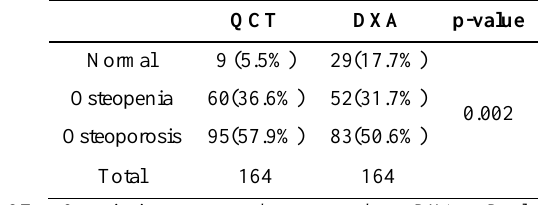
Table 3 : Comparison between the prevalence of osteopenia